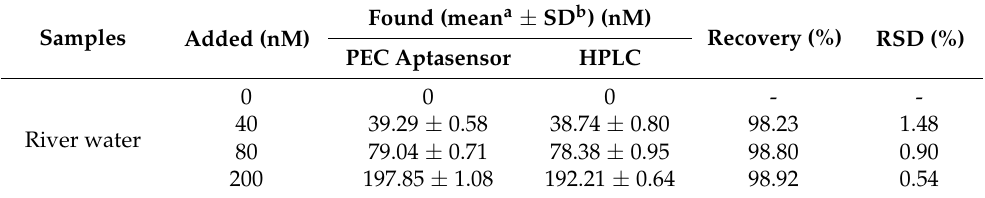
Table 2. Determination of TC in Real Samples Using the Developed Sensor.